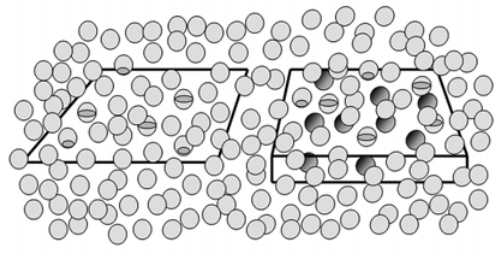
Fig. 6 – The Holmes effect not only interferes with size esti- mation, but also with the determination of volume ratio since particles overlap (right side). In sufficiently thin sections (left side) this problem doesn’t